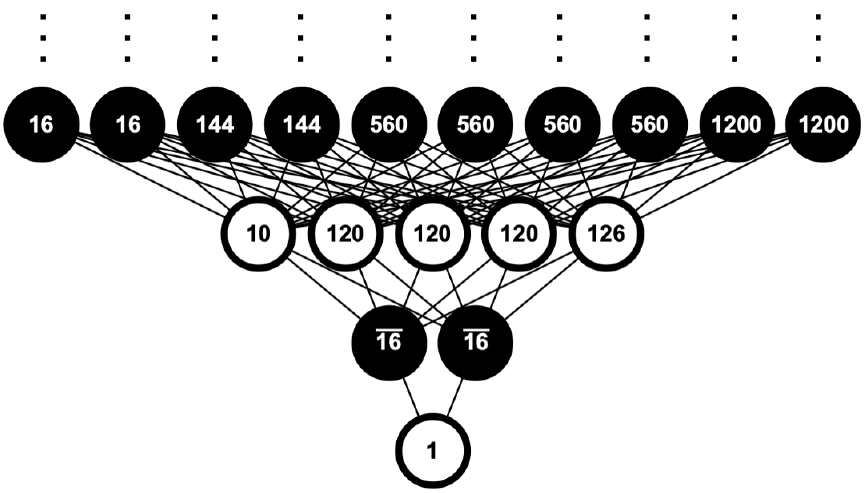
Figure 8 . Adinkra diagram for 10D, N = 2B at low